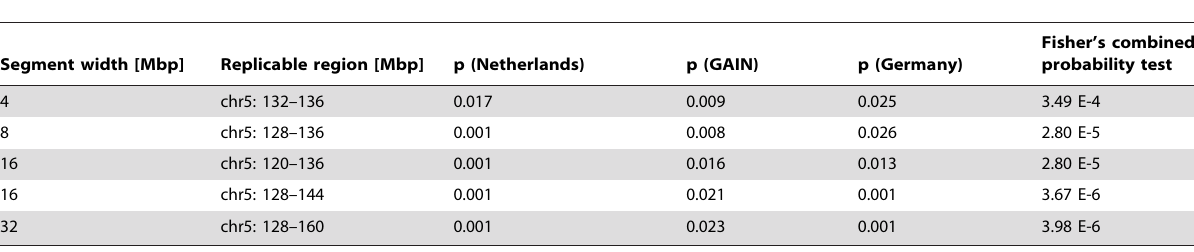
Table 1. Metasignificance of segments located in chromosome 5 (128–160 Mbp).